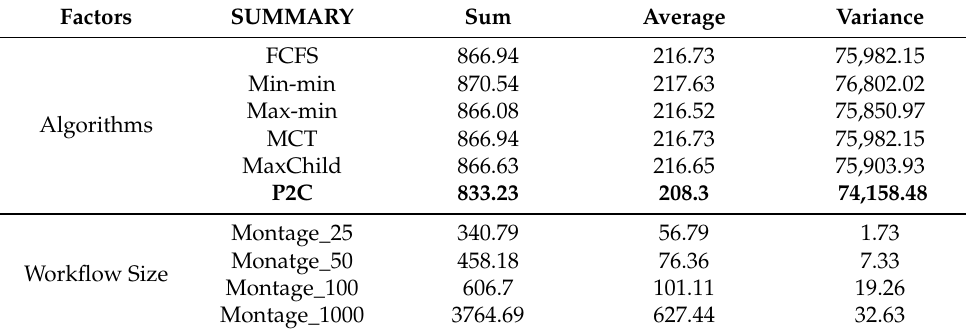
Table 8. Two way ANOVA Summary results for Montage Workflow.